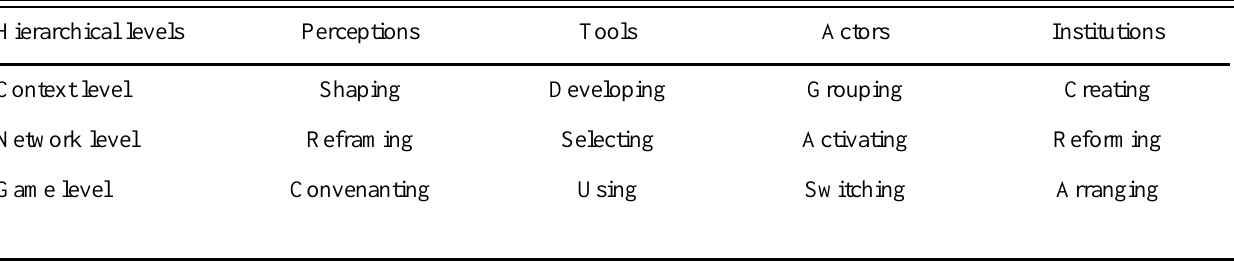
Table 2 . Water management hierarchies for adaptive management.